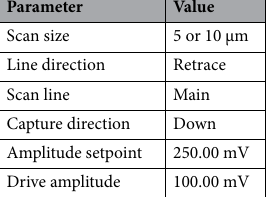
Table 3. AFM values of